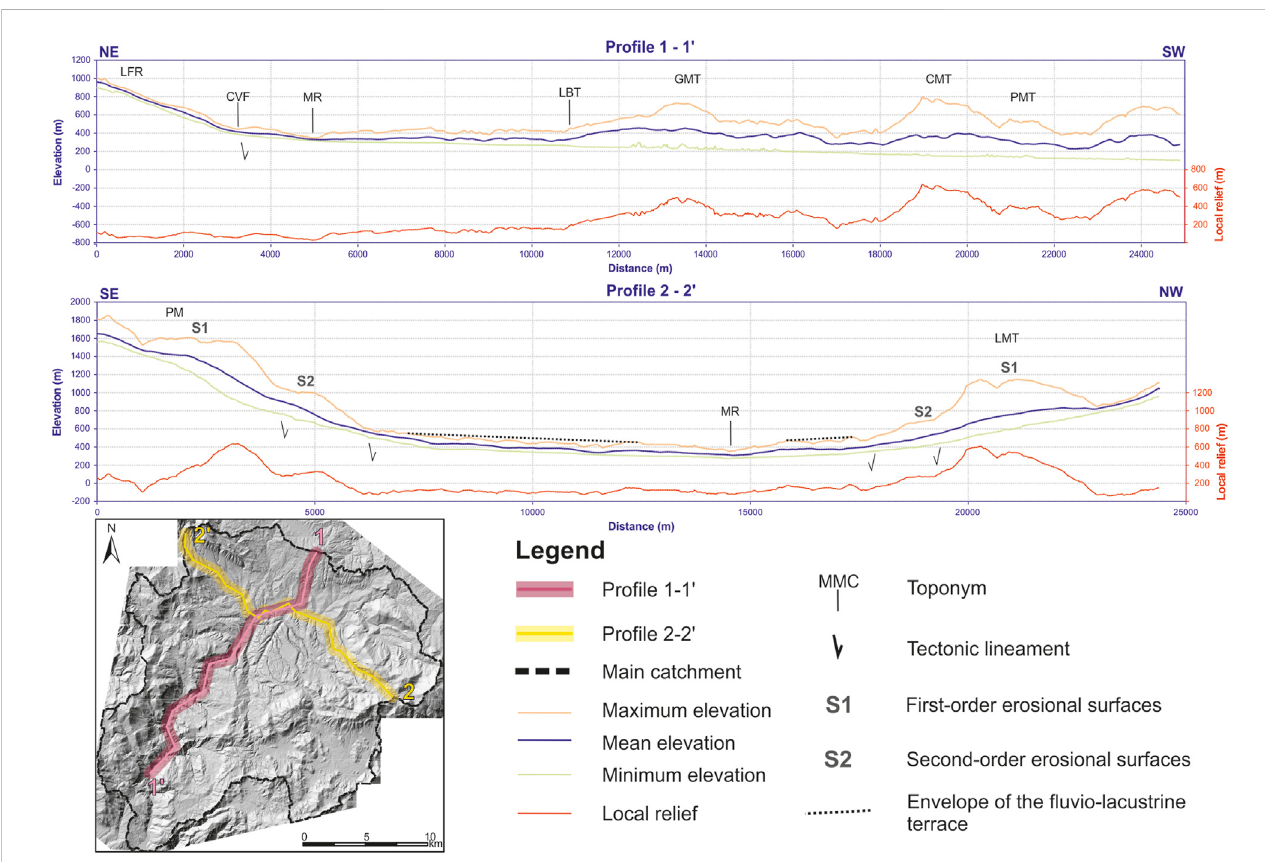
FIGURE 3 Topographicswathpro fi les(swathwidth:1,000 m)crossingtheMercureRiverbasin.Acronyms:LFR,laFagosaridge;CVF,Castelluccio-Viggianellofault; MR, Mercure River; LBT, Laino Borgo threshold; GMT, Gada Mts; CMT, Ciagola Mts; PMT, Papasidero-Mormanno Mts; PM, Pollino Massif; LMT, Lauria